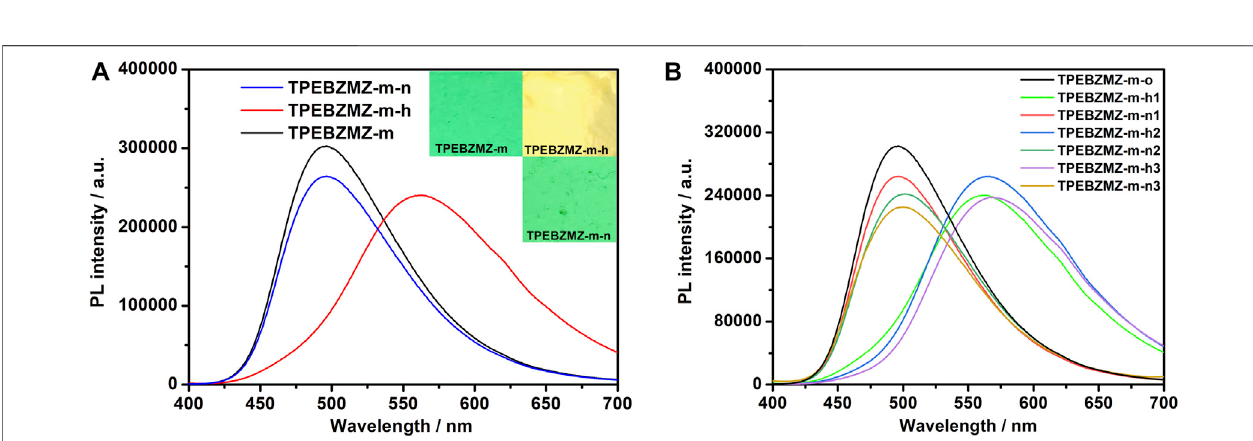
FIGURE7|(A) FluorescencespectraandimagesofTPEBZMZ-m:TPEBZMZ-m,theoriginalTPEBZMZ-basednano fi brous fi lm;TPEBZMZ-m-h,HCl-fumed(24 h) fi lm from TPEBZMZ-m (HClgaswasreleased from a37%concentrated HClaqueoussolution); TPEBZMZ-m-n, NH was released from a 25% concentrated NH 3 aqueous solution). (B) Repeated fl uorescence switch of TPEBZMZ-m by HCl fuming and NH 3 fuming cycles.